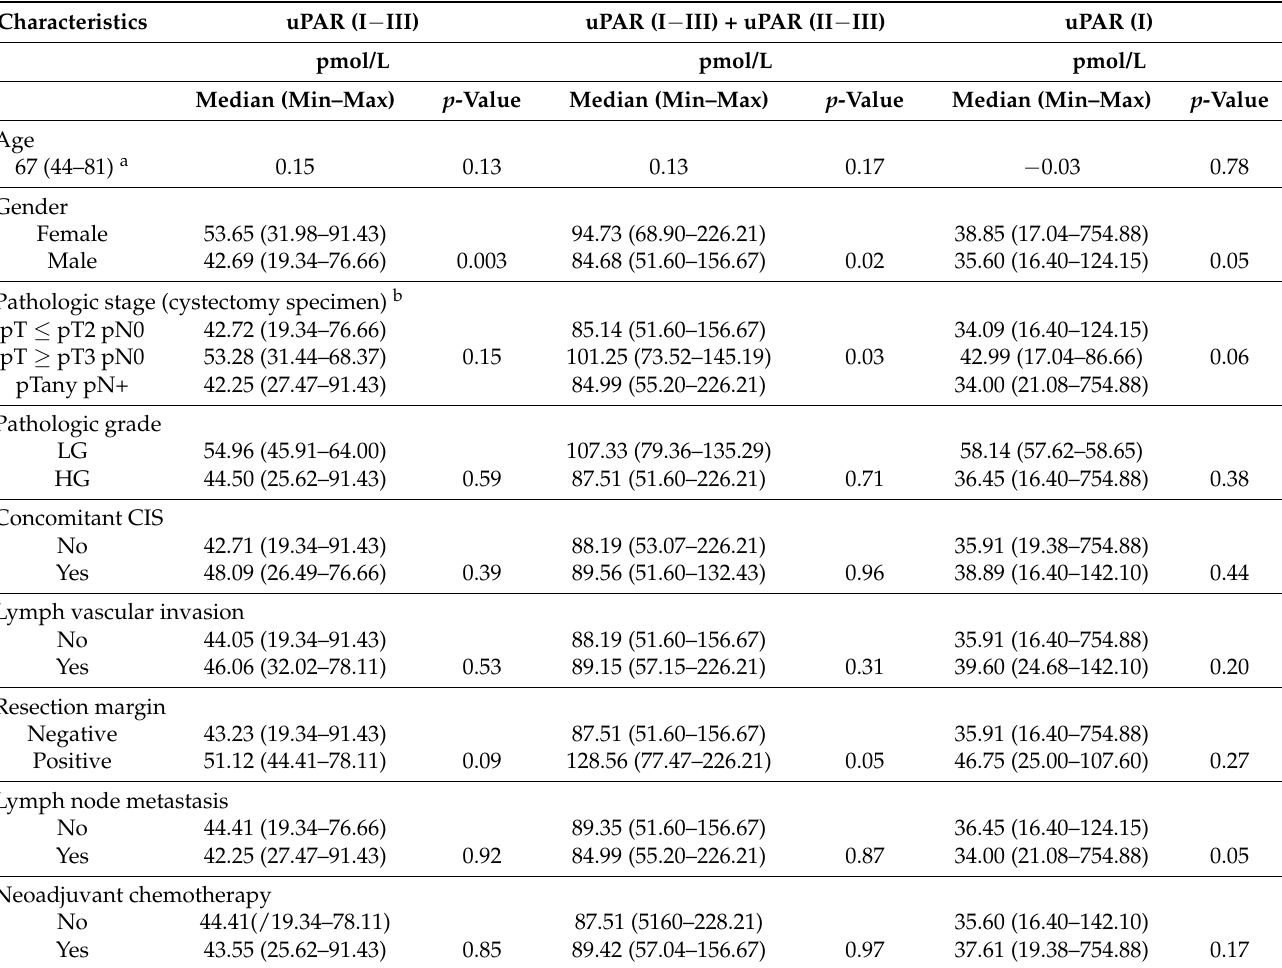
Table 2. Association of the preoperative plasma uPAR forms with clinical and pathological